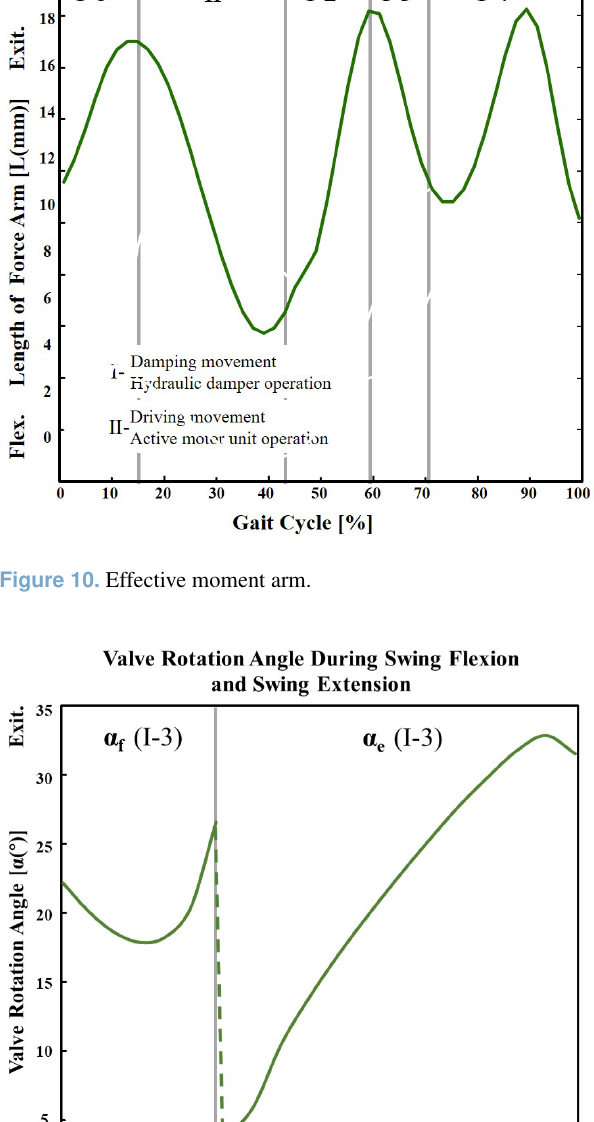
The AKP consumes more power at four different